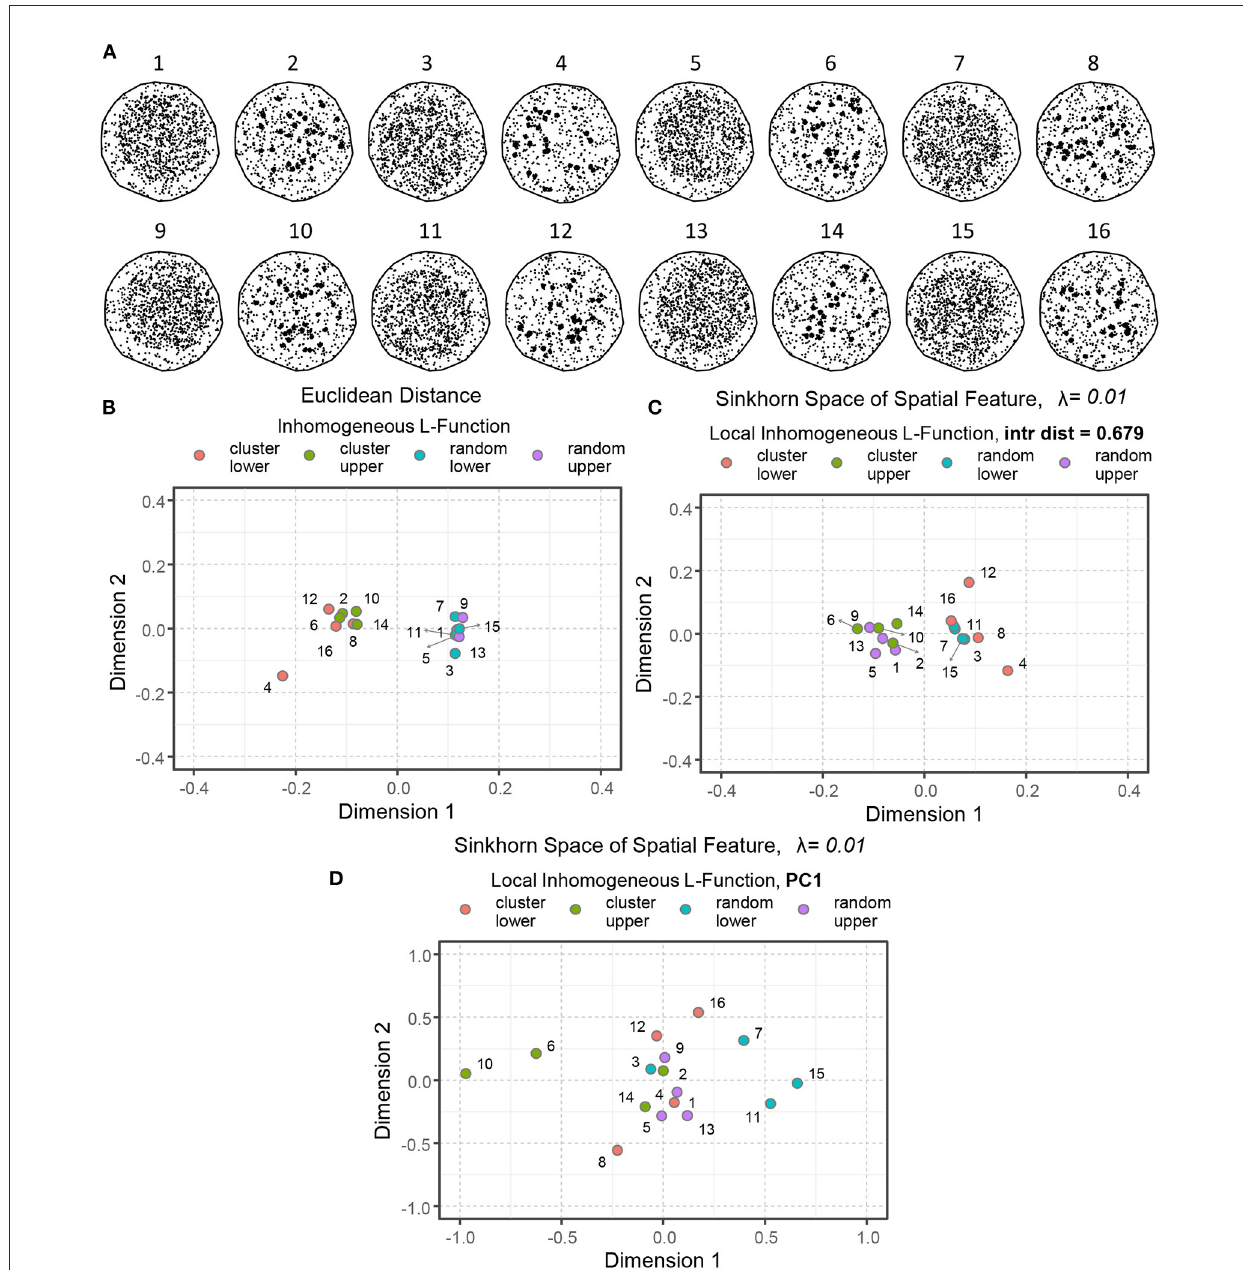
FIGURE8 An illustration of spatial point patterns with different interactions and regionality. (A) Simulated examples of spatial point patterns: concentrated in the upper right (1, 2, 5, 6, 9, 10, 13, 14) and the lower left (3, 4, 7, 8, 11, 12, 15, 16) corners demonstrate regionality. The points are organized randomly in the odd-numbered examples and clustered in the even-numbered instances. (B) Euclidean distance between the inhomogeneous L -functions of the simulated models. (C) Sinkhorn distance between the local inhomogeneous L -functions of the simulated examples at a large interaction distance ( r = 0.679). (D) Sinkhorn distance between the first principal component (PC) of local inhomogeneous L -functions of the simulated examples over a set of interaction distances. The point patterns of different interactions and regionality are shown in different